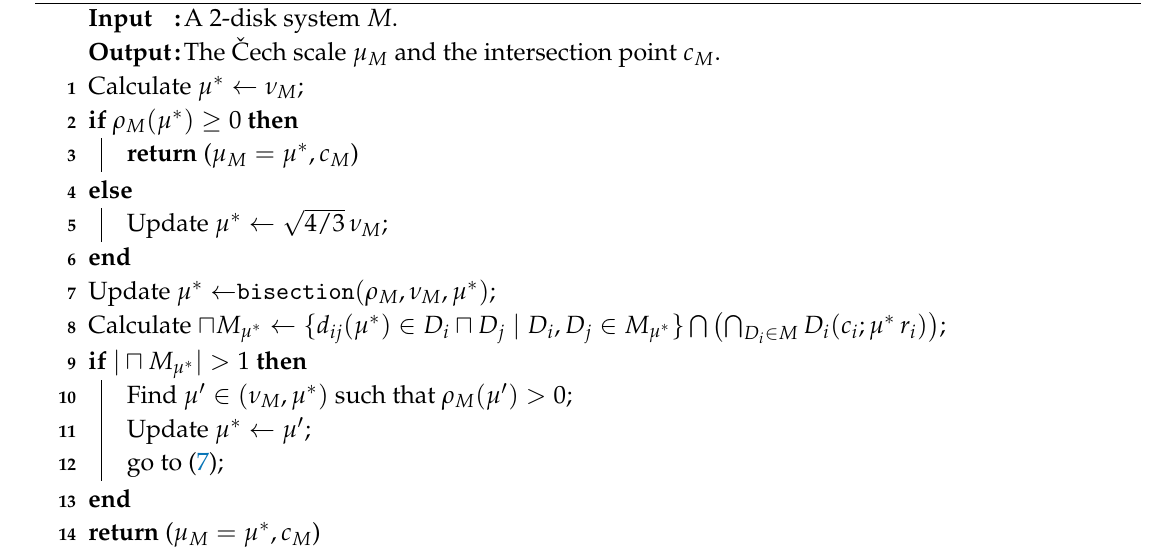
Algorithm 2: The ˇCech scale calculation for a 2-disk system.